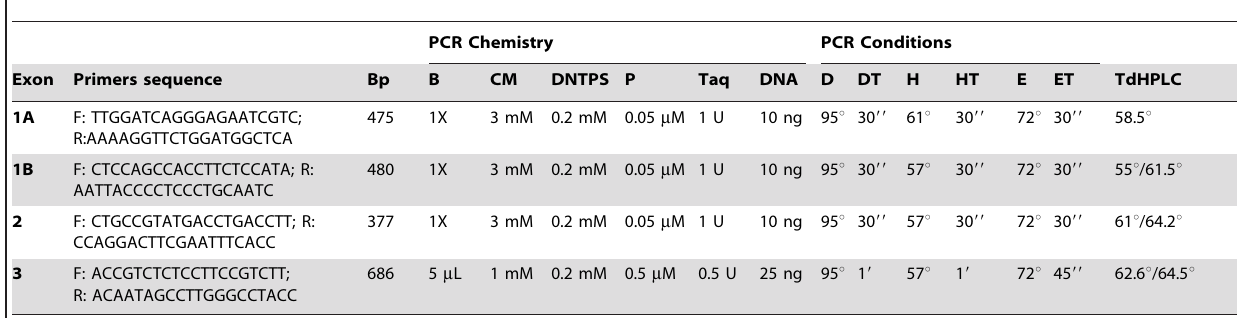
Table 1. Amplification and dHPLC conditions for PHOX2B genomic sequence analysis.